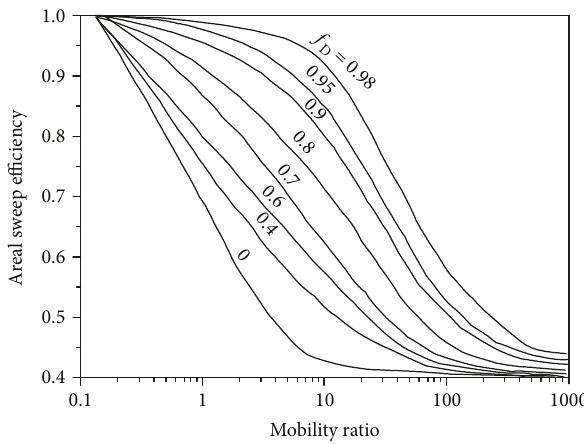
Figure 2: Areal sweep e ffi ciency a ff ected by the mobility ratio